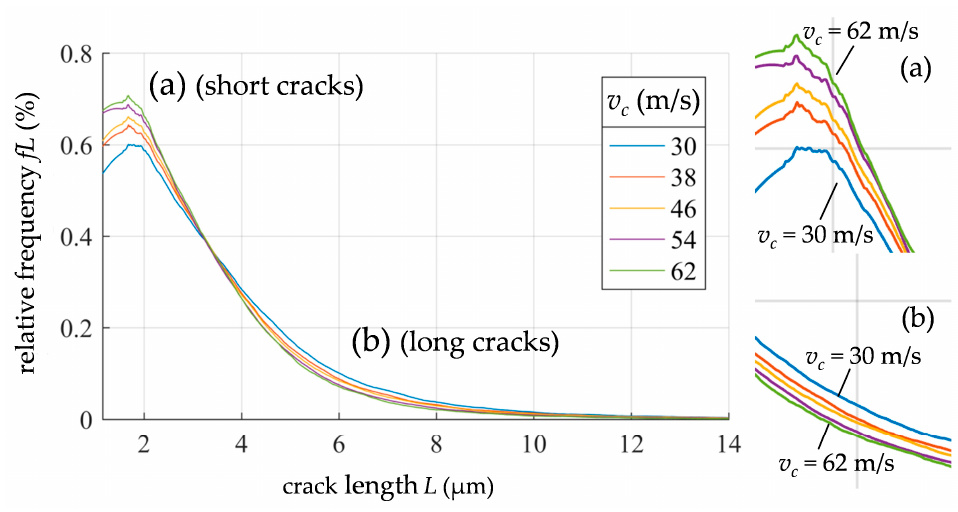
Figure 9. Relative frequencies of the crack length L (filtered data).